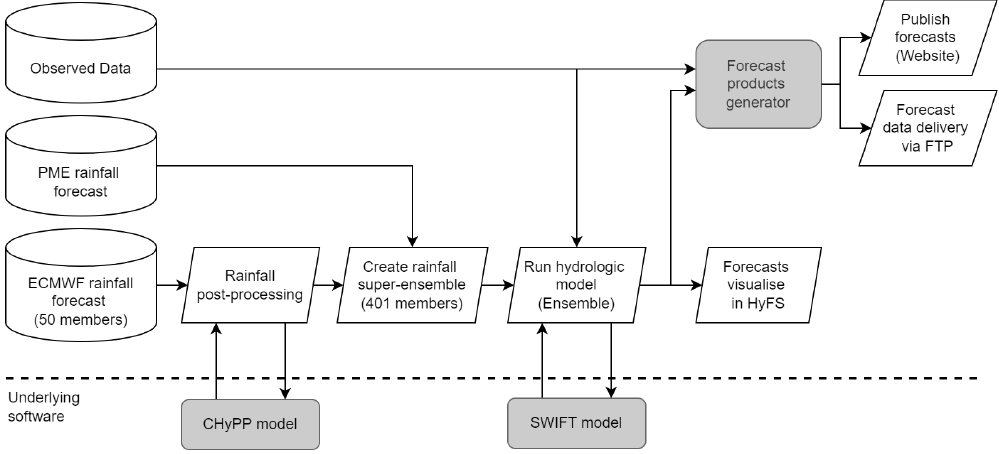
Figure 12. Operational forecast system (HyFS workflow level). Table 4. Hydrologic model performance statistics for 283 forecast